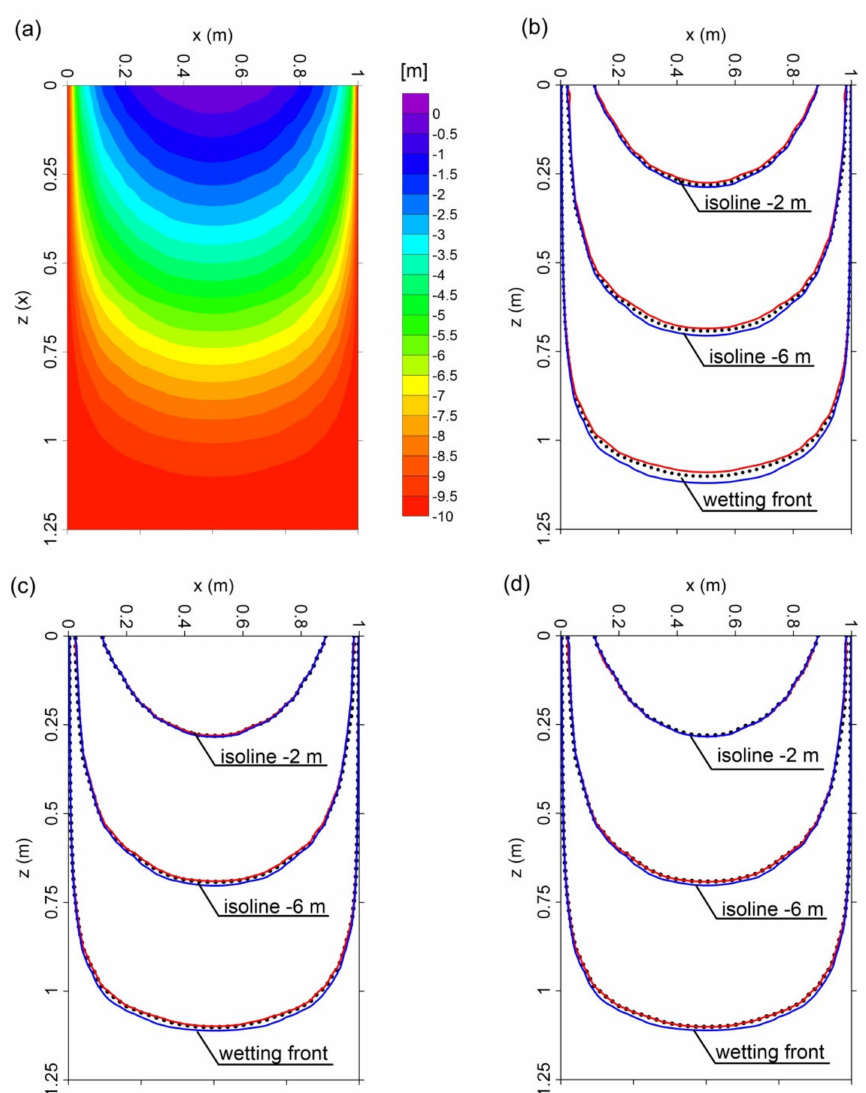
Figure 5. Pressure head distribution after 1000 s for analytical solution ( a ); numerical solutions in the form of isolines of the pressure head ( ∆ t = 50 s, η = 0.5) obtained using various splitting methods: Godunov ( b ); standard Strang ( c ); modified Strang ( d ). The dashed line indicates analytical solution, and red and blue lines are solutions for sequences ZX and XZ,